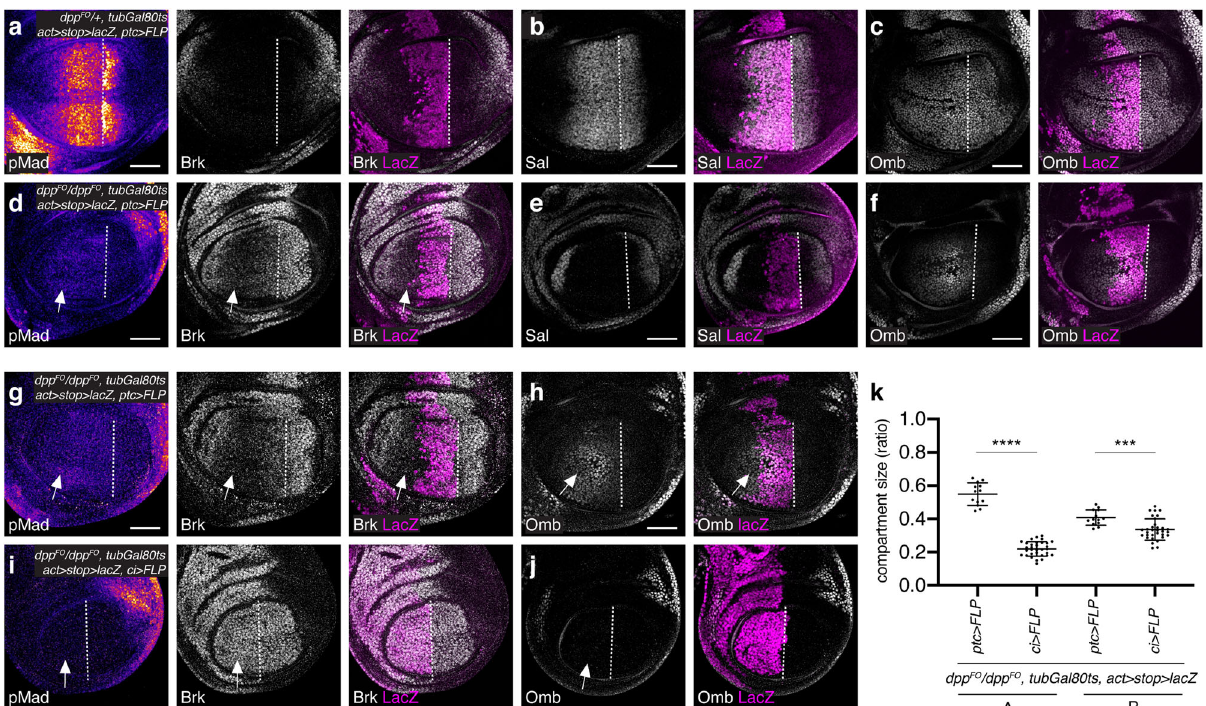
Fig. 8 Transient anterior dpp source outside Sal domain is required for anterior patterning and growth. a − f α -pMad, α -Brk, and α -LacZ ( a , d ), α -Sal and α -LacZ ( b , e ), α -Omb and α -LacZ ( c , f ) staining of dpp FO / + , tubGal80ts, act > stop > lacZ, ptc > FLP control wing disc ( a − c ) and dpp FO /dpp FO , tubGal80ts, act > stop > lacZ, ptc > FLP wing disc ( d − f ). Crosses were shifted from 18 °C to 29 °C at 5-day AEL (mid-second instar). α -LacZ staining marks the region where dpp is removed upon FLP expression. Dashed white lines mark the A − P compartment border. Scale bar 50 μ m. g − j α -pMad, α -Brk, and α -LacZ ( g , i ), α - Omb and α -LacZ ( h , j ) staining of dpp FO /dpp FO , tubGal80ts, act > stop > lacZ, ptc > FLP wing disc ( g , h ) and dpp FO /dpp FO , tubGal80ts, act > stop > lacZ, ci > FLP ( i , j ). The genotypes of the wing discs in ( d − f ) and in ( g , h ) are identical. Crosses were shifted from 18°C to 29°C at 5-day AEL (mid-second instar). α -LacZ staining marks the region where dpp is removed upon FLP expression. Dashed white lines mark the A − P compartment border. Scale bar 50 μ m. k